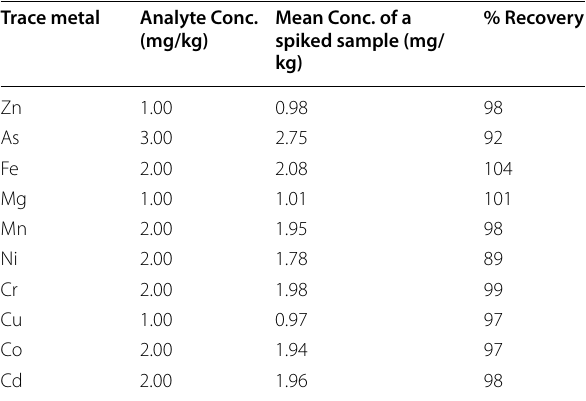
Table 3 Method efficiency data for analysis of ten trace metals in spiked surface sediment samples Trace metal Analyte Conc.